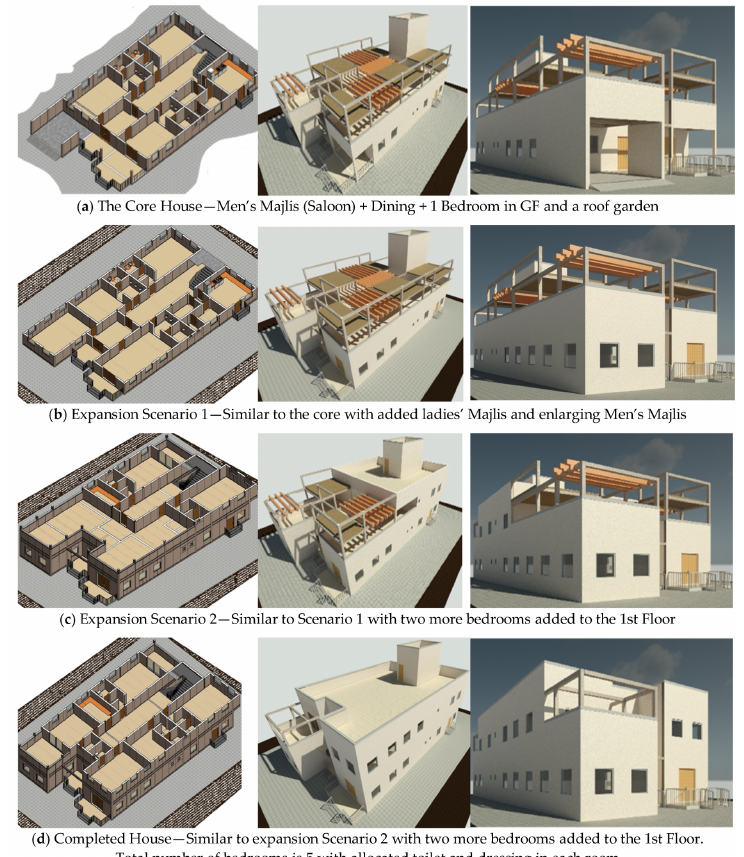
Figure 7. Examples for incremental expansions (contractions) scenarios from core ( a ) to complete ( d ) in a BIM